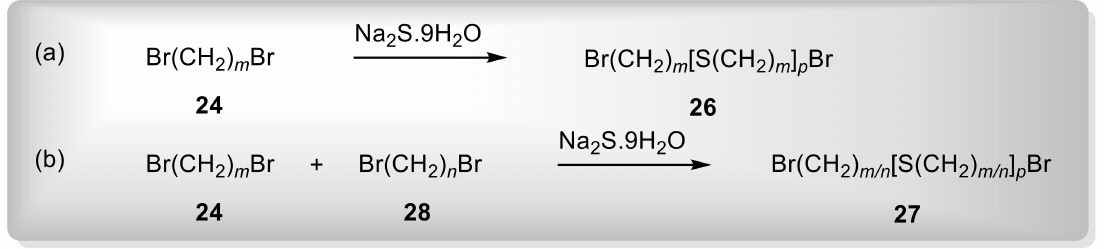
Table 4. Some polymers 26 and 27 prepared according to Scheme 4 a . Entry Polymer Number m of Dibromide 24 n of Dibromide 28